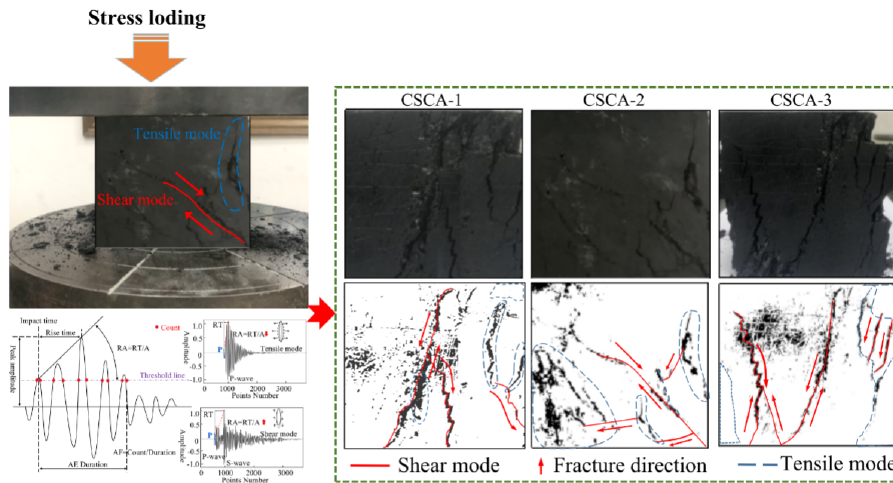
Figure 8. Fracture characteristics of coal samples.